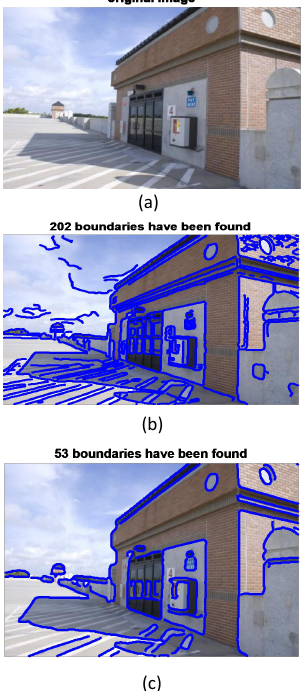
Figure 2. ( a ) Original image. ( b , c ) Canny edge detection with parameters computed by the default approach ( b ) and with threshold values of 0.08, 0.2 and standard deviation of the Gaussian filter σ = 3 ( c